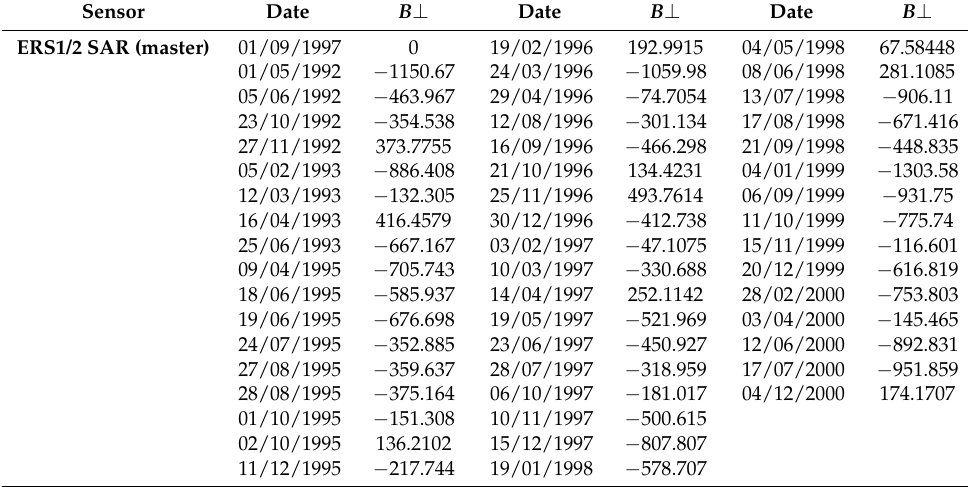
Table A1. ERS images dates and perpendicular baseline B ⊥ relative to the master image (01/09/1997).